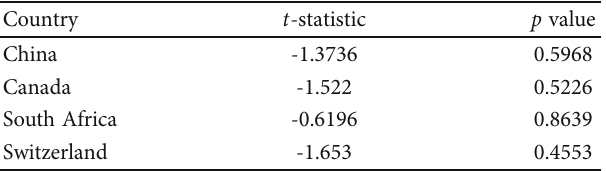
Table 4: ADF test for the random walk property of the series.